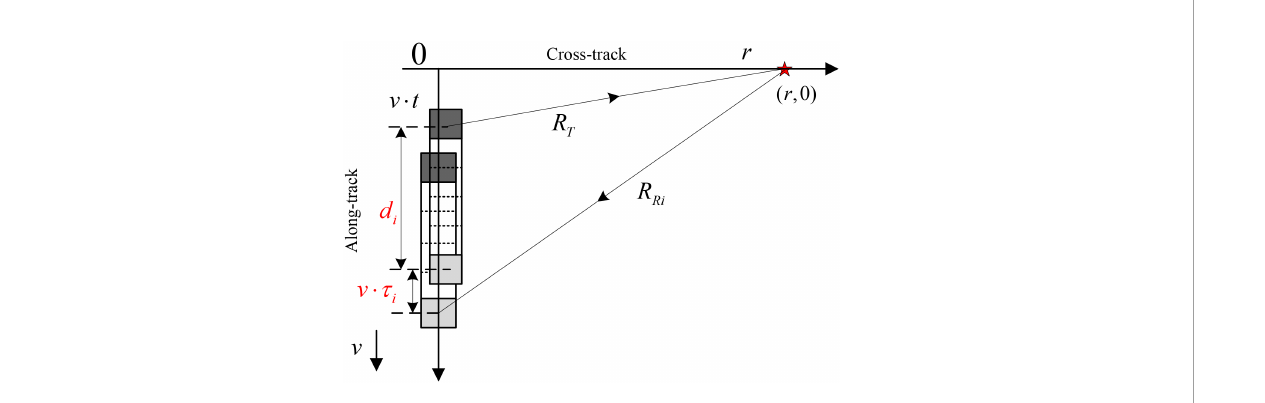
FIGURE 1 Multiple-receiver synthetic aperture sonar (MSAS) imaging